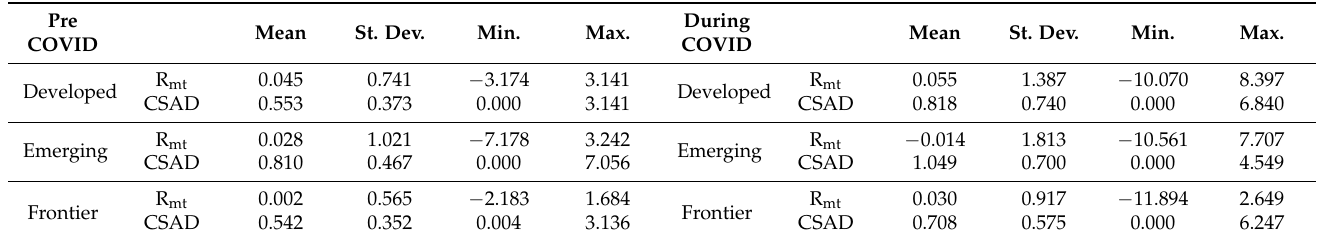
Table 1. Descriptive statistics of herding and market return.